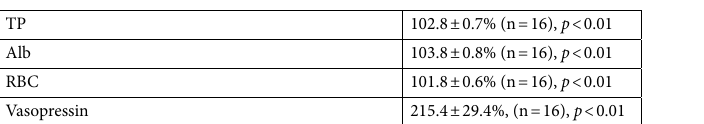
Table 1. The compared data of TP, Alb, RBC, and vasopressin in blood in all participants obtained before and after the 30 min physical exercise. Each value normalized with one obtained before the exercise.